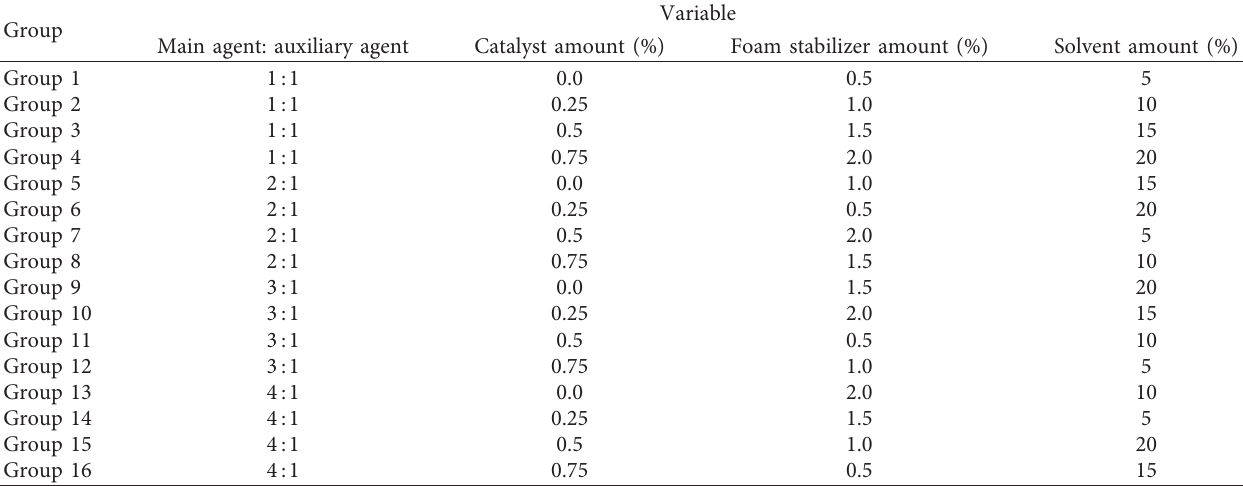
Table 2: Orthogonal design table.